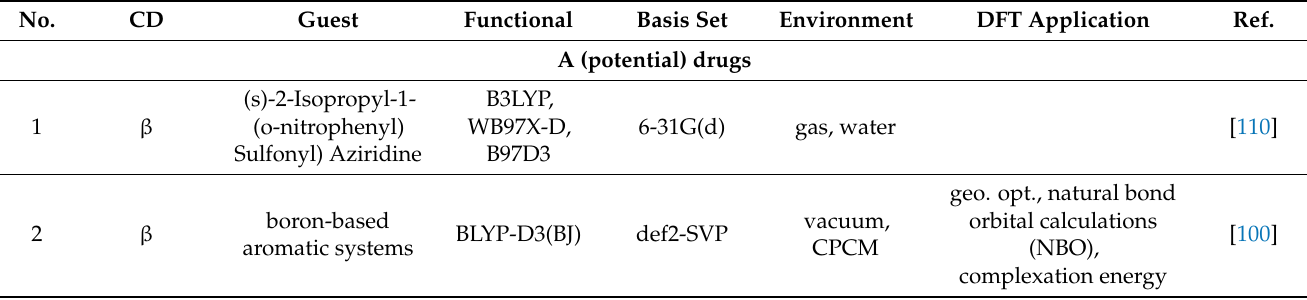
Table 1. Selected articles published in the years 2015–2022 on the application of DFT methods for systems that included CD. The functional and basis set information concerns CD complexes, not guests. Abbreviations used in table: DM-CD (2,6-dimethylo-CD), TM-CD (trimetylo-CD),